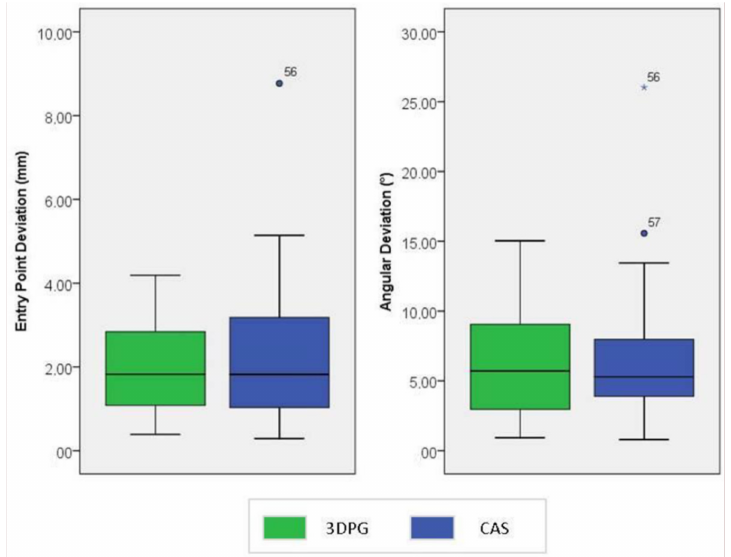
Figure 4. Entry point deviation (in mm) and angular deviation (in ◦ ) for screws used in the 3DPG (green) and CAS (blue) study